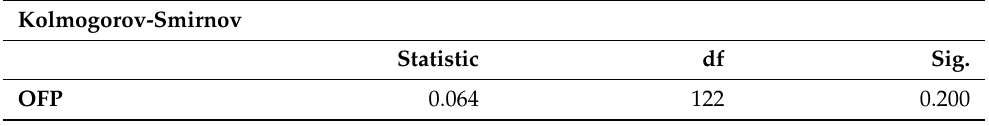
Table A1. Test of Normality. Source: Compiled by the Authors. Kolmogorov-Smirnov